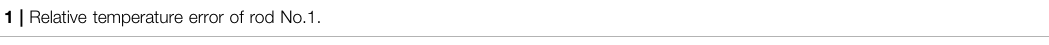
TABLE 1 | Relative temperature error of rod No.1. Relative